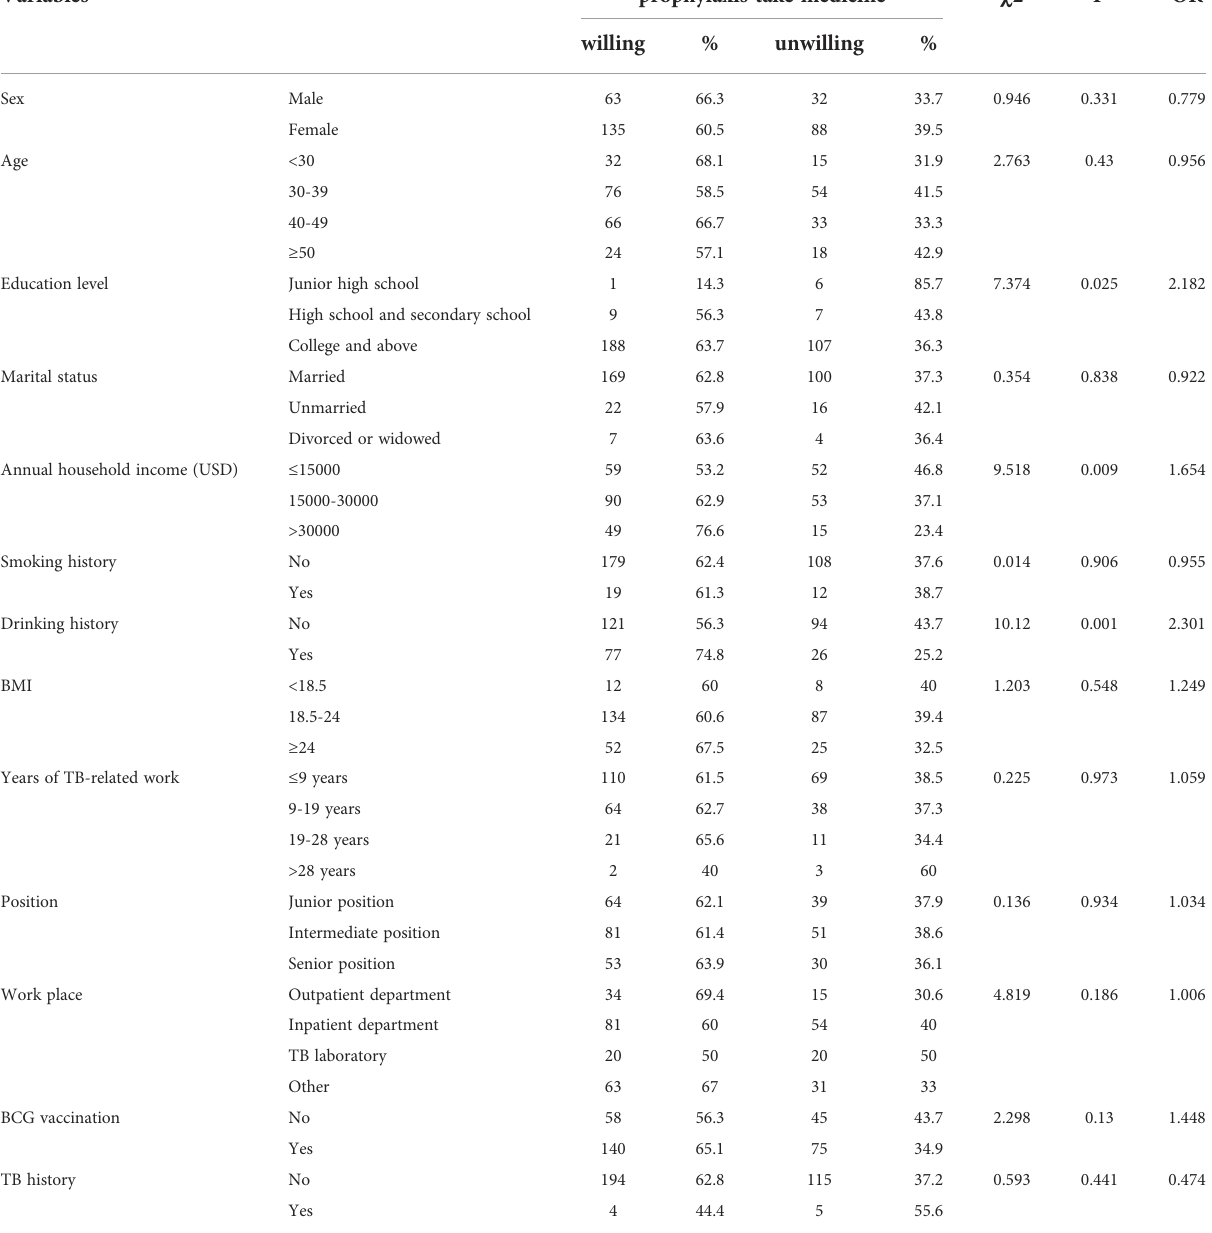
TABLE 2 Different characteristics of TB-related health workers willingness to take prophylaxis